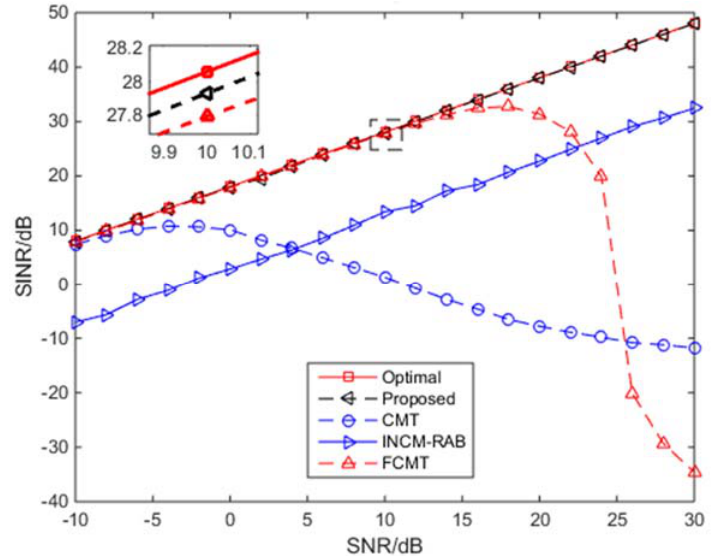
Figure 4. The relationship between output SINR and input SNR. Experiment 4: Anti–interference ability verification—Relationship between interference mismatch angle and output SINR.